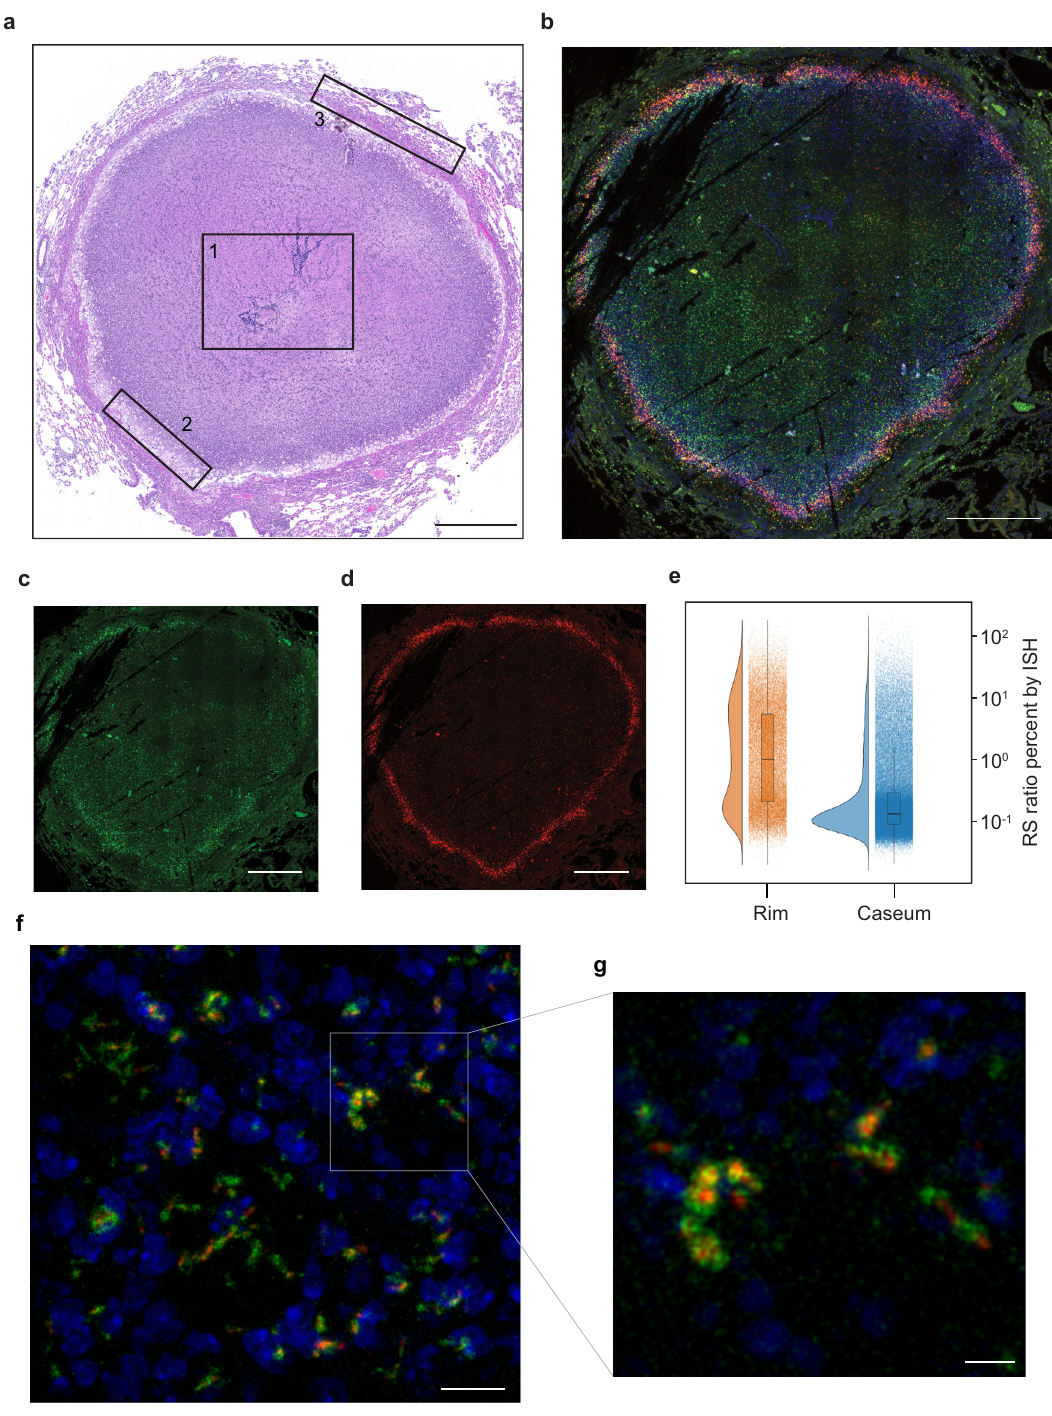
Sterilizing potency and rRNA synthesis in vitro . We tested canonical TB antimicrobials for effects on rRNA synthesis using in vitro time-kill experiments. Drugs with well-established ster- ilizing potency included rifampin, bedaquiline, and pyrazinamide. Pyrazinamide was excluded from in vitro analysis because its full activity requires in vivo conditions 27 . The well-established non- sterilizing drugs examined included isoniazid, streptomycin, and ethambutol. We used drug concentrations that maximally decreased Mtb CFU (up to 99% after 3